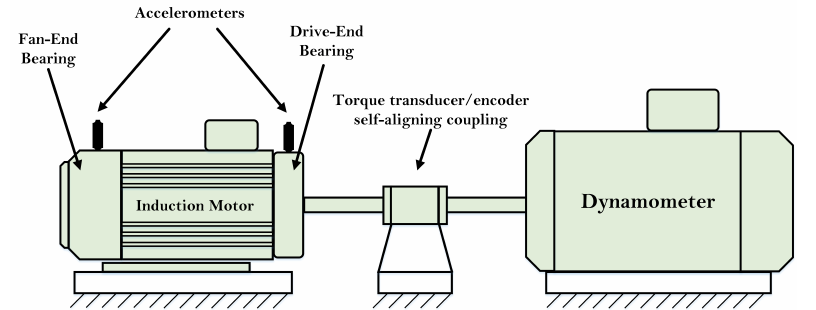
Figure 4. CWRU bearing test rig [34].